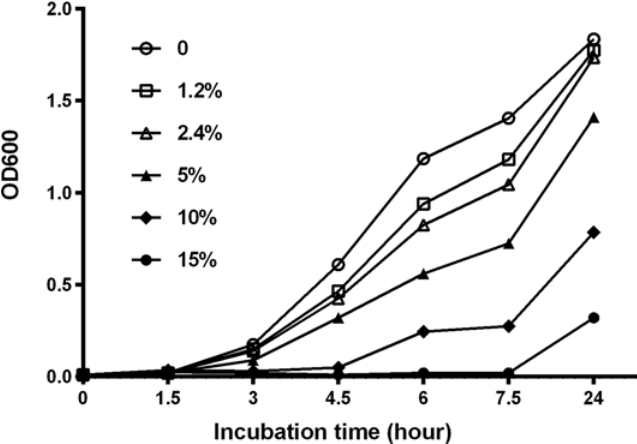
10.0 or15.0% (w/v) of ox bile and grown in a 37°C incubator with shaking at 220 RPM. OD 600 of each culture was recorded at 1.5 hour intervals. The OD 600 value represents the mean ± SD of three independent cultures.